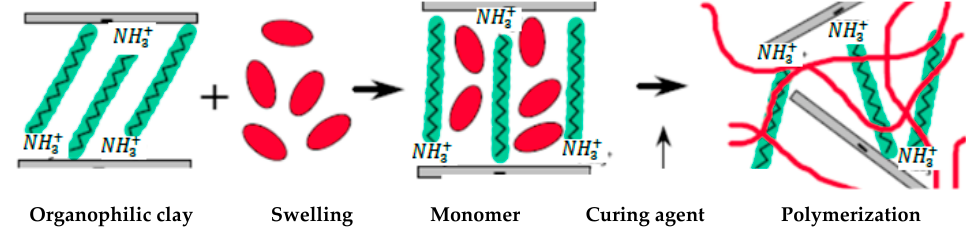
Figure 8. In Situ techniques for the preparation of polymer/clay nanocomposites.